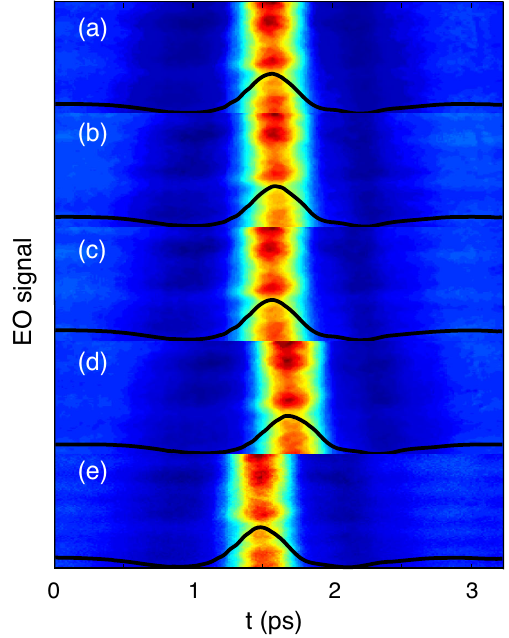
FIG. 8. (a) – (e)Single-shotEOsignaloffive consecutive bunches at one electric field direction (such as bottom part of Fig. 4). The blacksolidlineistheprojectionoffieldstrengthontimecoordinate.